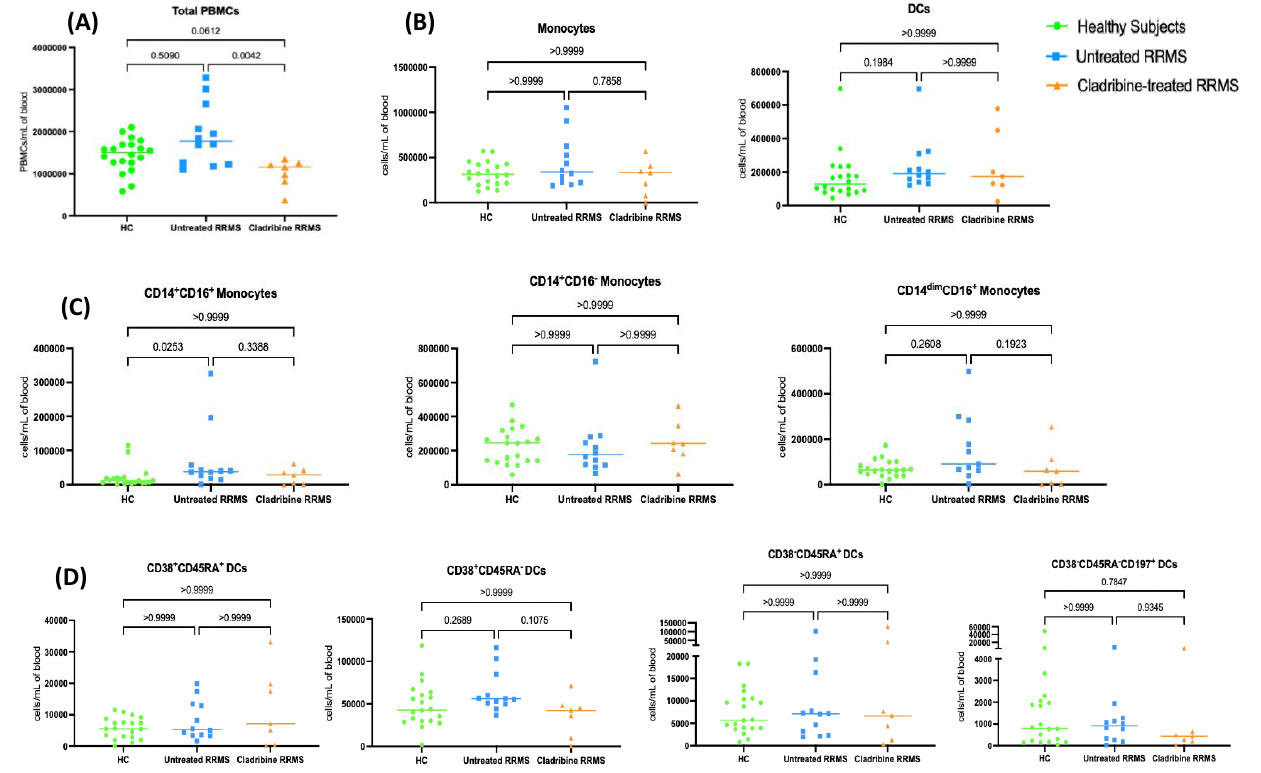
Figure 2. Cladribine has no effect on circulating monocyte or DC levels. Fresh PBMCs were immediately collected and phenotyped from healthy subjects ( n = 20), untreated RRMS patients ( n = 12) and cladribine–treated RRMS patients ( n = 7). ( A ) Total fresh PBMCs/mL of blood. ( B ) Total numbers of monocytes and DCs per millilitre. ( C ) Total numbers of monocyte subsets per millilitre. ( D ) Total numbers of DCs subsets per millilitre. Analyses were conducted with Kruskal–Wallis nonparametric one–way ANOVA with Dunn’s multiple comparisons test. The significance was dictated by p < 0.05.